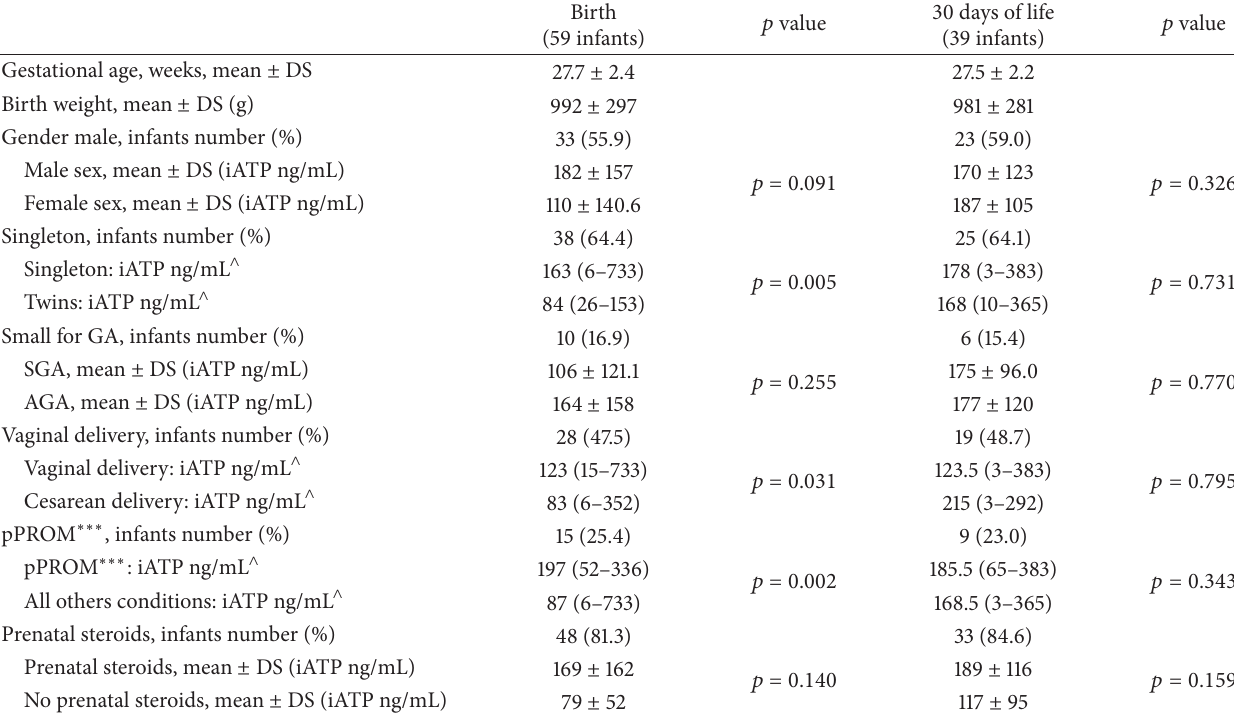
Table 2: Characteristics at birth of infants enrolled in the study: median (range); GA: gestational age; SGA: small for gestational age; AGA: appropriate for gestational age; ∗∗∗ pPROM: prolonged Premature Rupture of Membranes: a case of premature rupture of membranes in which more than 18 hours has passed between the rupture and the onset of